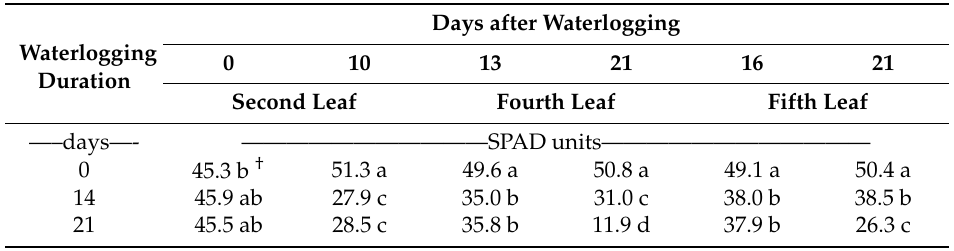
Table 2. Chlorophyll meter readings measured for the second, fourth, and fifth corn plant leaves as affected by the waterlogging